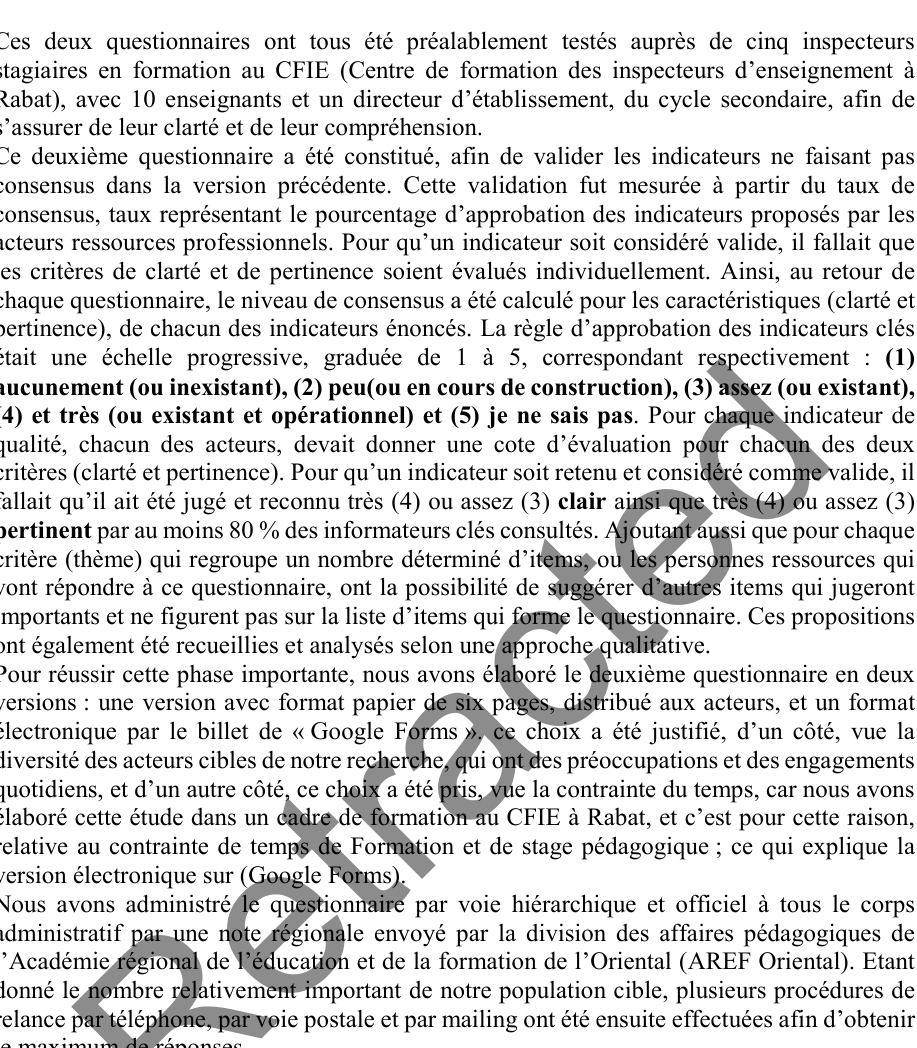
Figure 4 : Les étapes de l’analyse